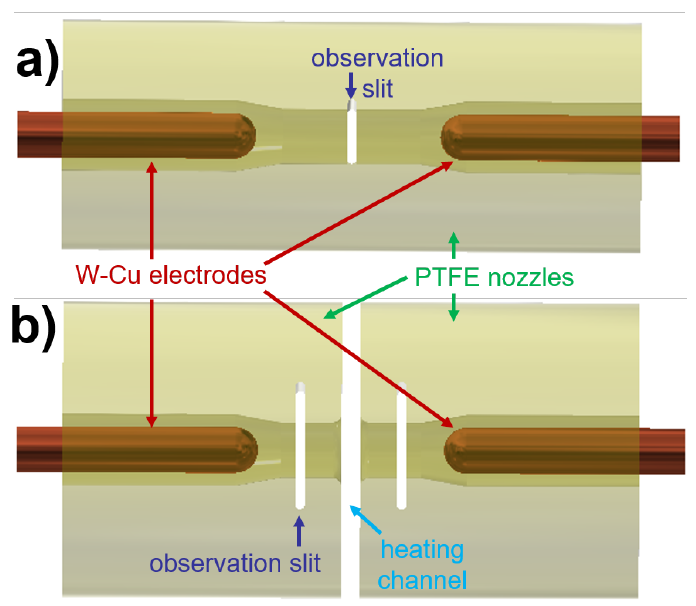
Figure 1. Setups ( a ) with a closed, long PTFE nozzle for experiments with strong ablation and high pressure built-up and vertical observation slits in the middle and ( b ) with two separated PTFE nozzles forming a heating channel for plasma flow into a heating volume as used for the model circuit